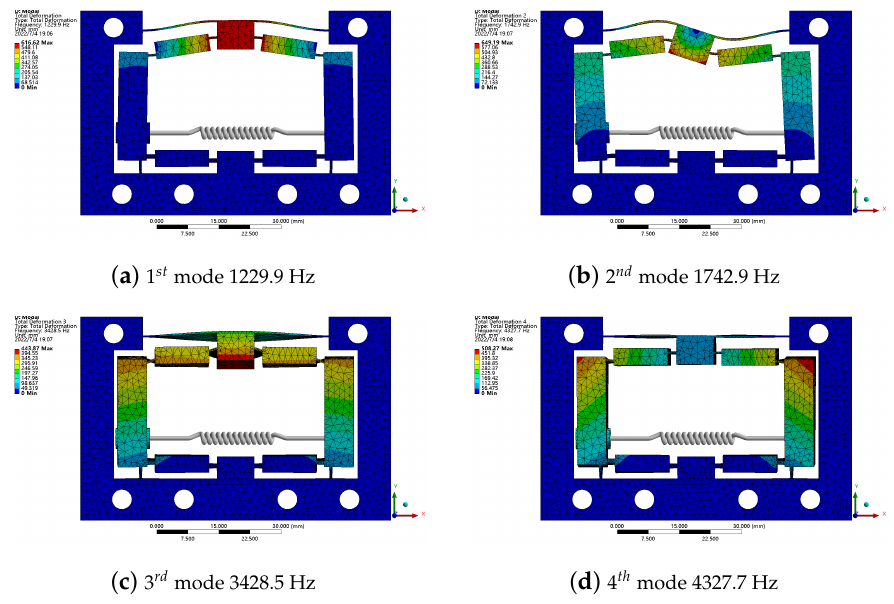
Figure 14. The first four order mode vibration shapes of the HBLB.